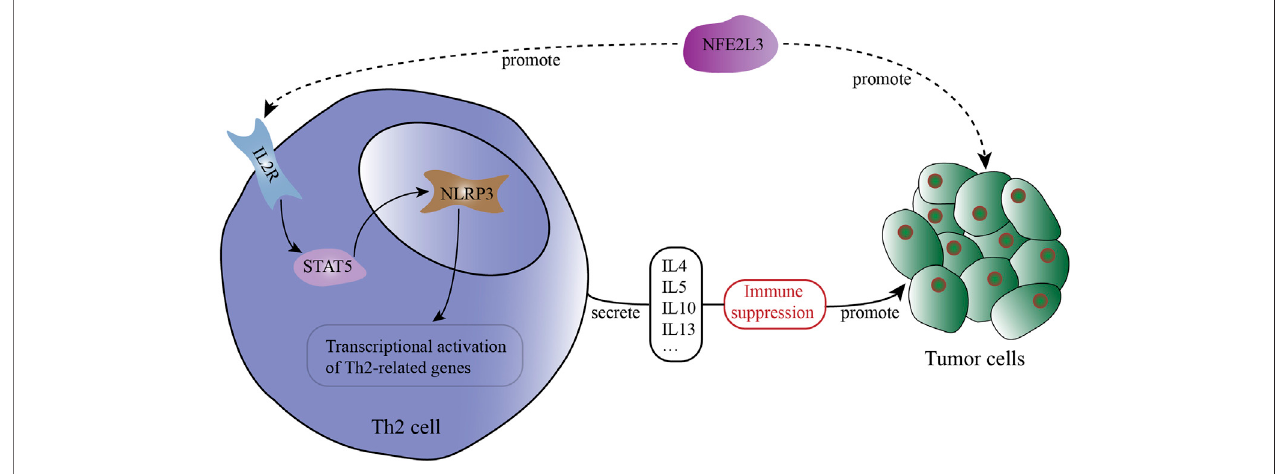
FIGURE 6 | The potential interactions across NFE2L3, IL-2R, STAT5, NLRP3, Th2 cell and tumor cells in the tumor microenvironment